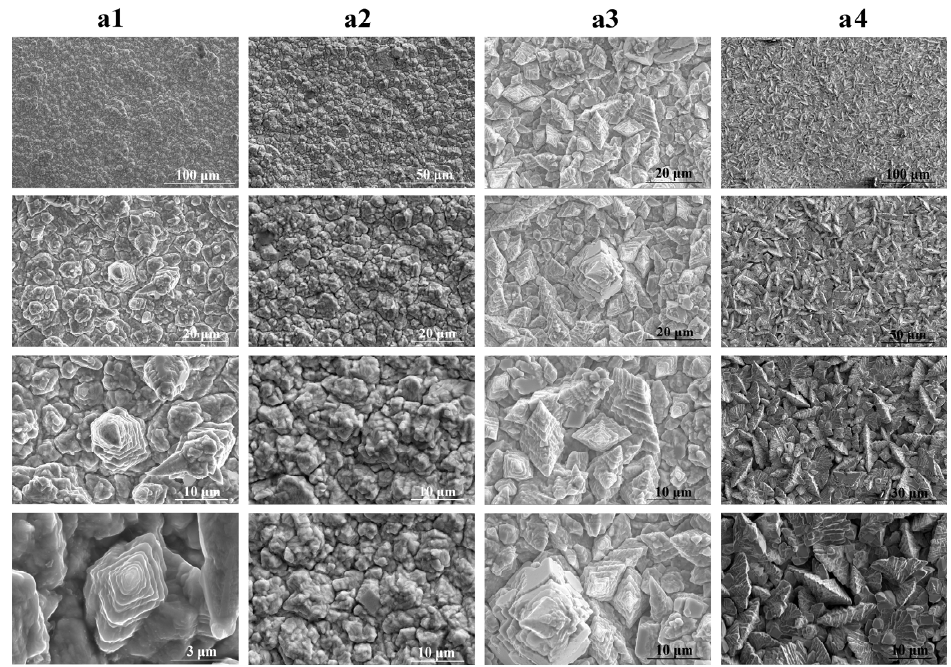
Figure 8. SEM images of copper surface under different reverse pulse frequency. ( a1 ) is 100HZ;